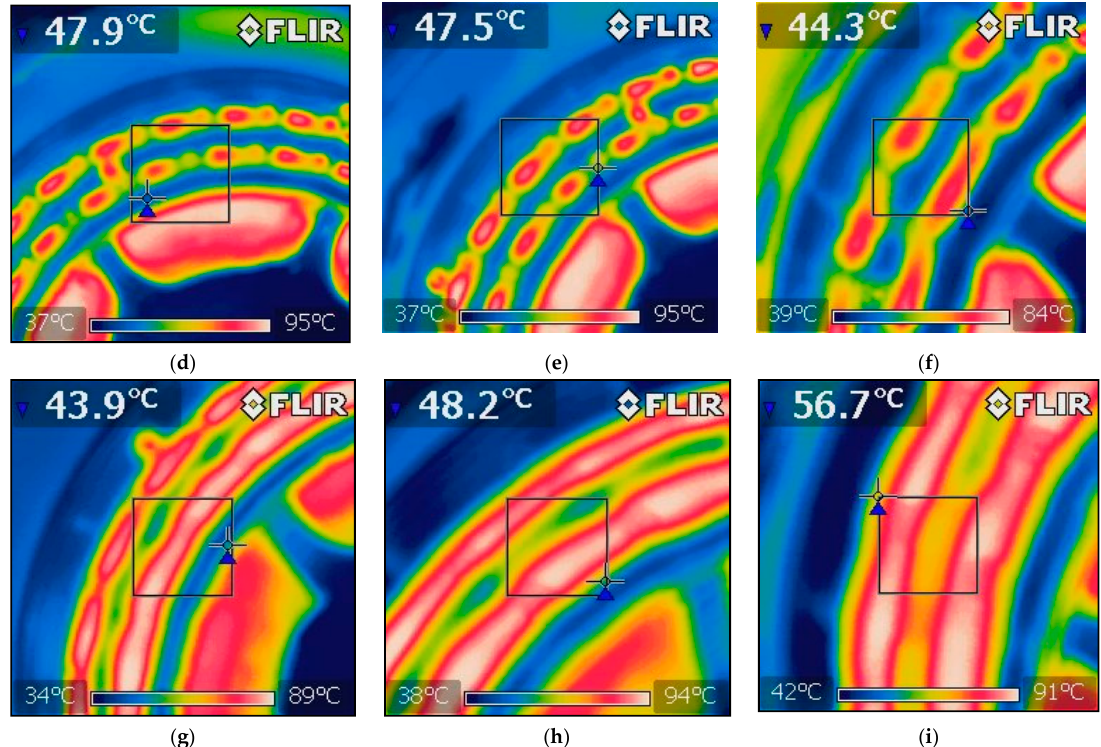
Figure 4. Thermal imprints on rotors before and after milling of 1 kg of individual batches: ( a ) new rotor with two rows of pins (rotation direction is marked by white arrow); ( b ) new rotor; ( c ) 200 m 2 /kg;